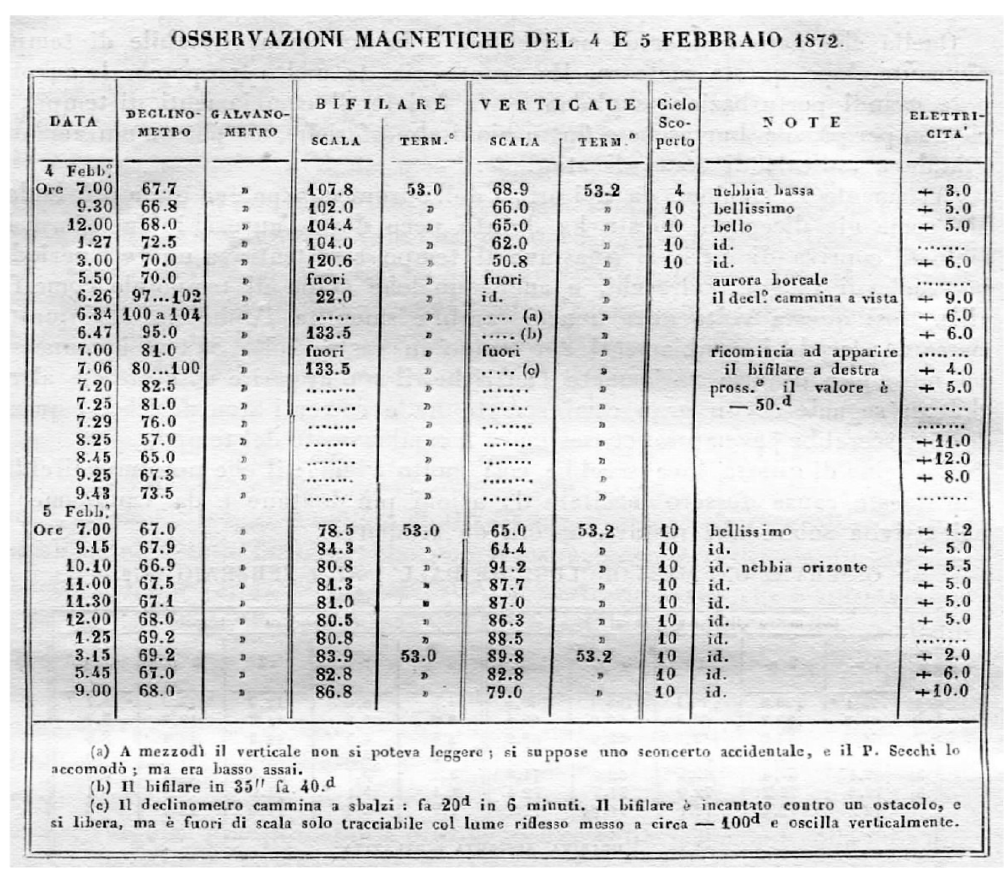
Fig. 3. Table of magnetic and electrical observations of 4 and 5 February 1872 carried out in the laboratories of the Roman College. The different columns record: the date and time (Rome solar time), the magnetic declination, the electric current measured by a galvanometer, the variations of the horizontal and vertical components of the magnetic fi eld (and relative instrument temperatures), sky coverage and general notes, electrical measurements. From the note Memoria sull ’ Aurora Elettrica del 4 Febbraio 1872 (Secchi,